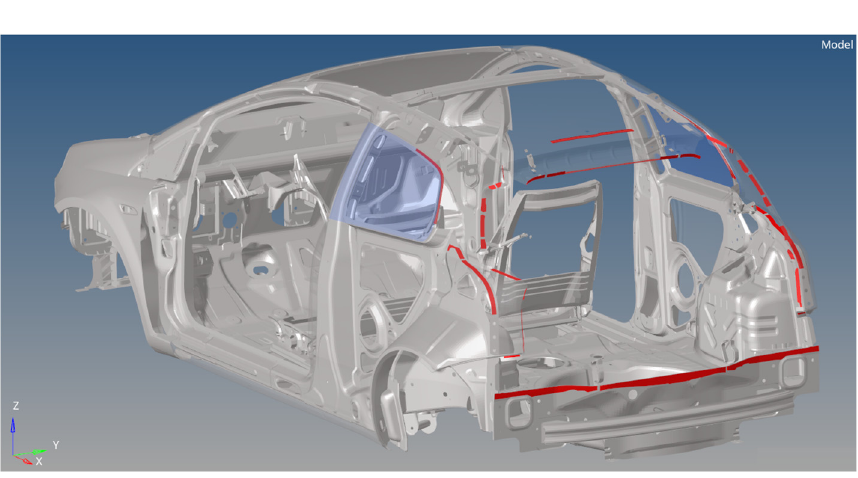
Figure 11. Connections with glue, highlighted in red, in the rear part.